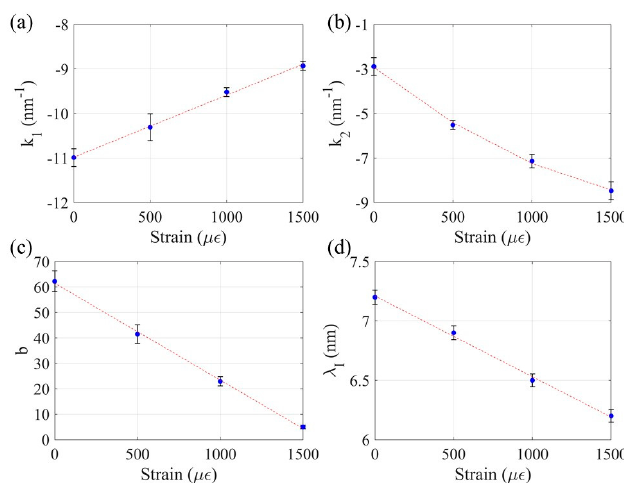
Figure 16. Curve fitting of ( a ) Stage I sensitivity, ( b ) Stage II sensitivity, ( c ) Intercept mass loss in Stage II correlation, and ( d ) Wavelength shift at the end of Stage I.